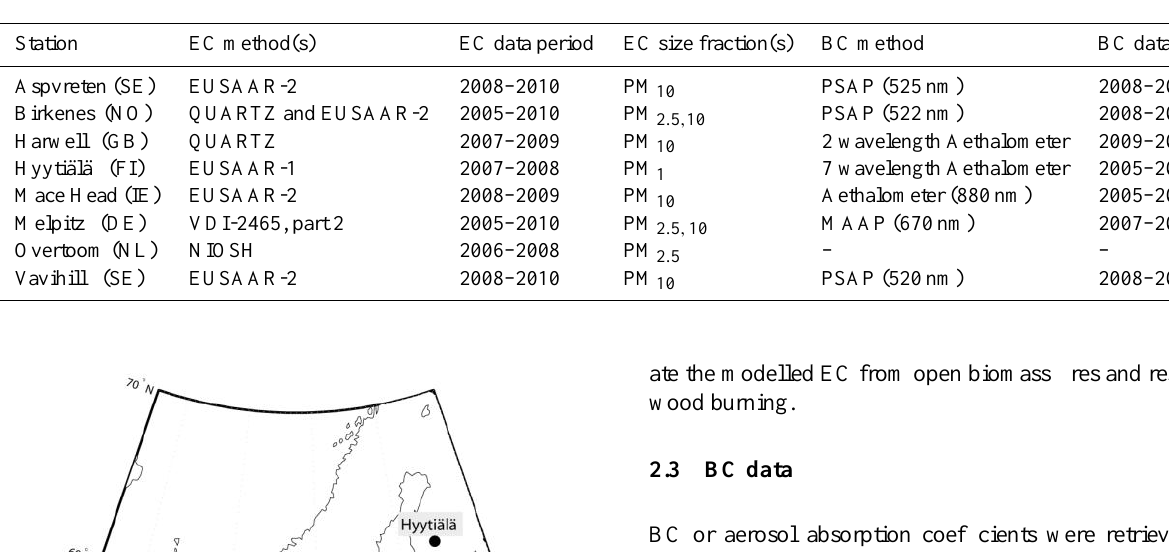
Table 1. EC and BC measurement techniques and data availability for the stations included in this work.